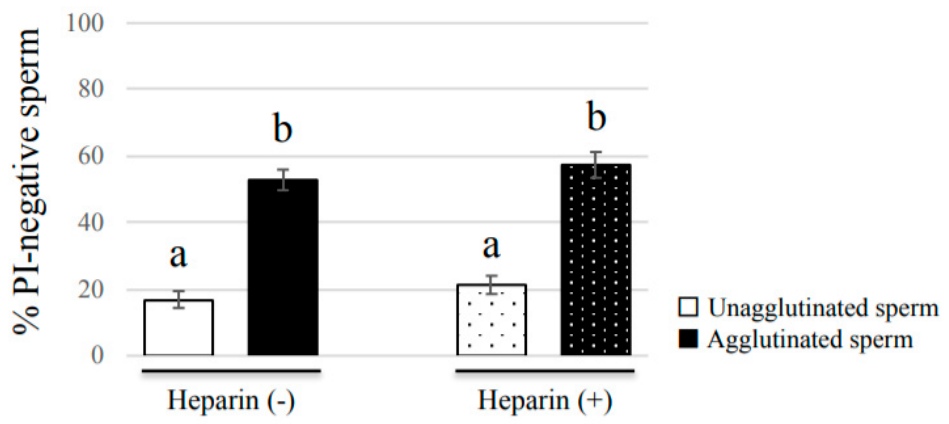
Figure 6. Effect of heparin on the % of PI-negative agglutinated or unagglutinated sperm. Bull sperm samples were stained with SYBR/PI, and incubated in non-capacitation medium supplemented with or without heparin for 2 h. Data shown as the mean ± SE ( n = 4). Different letters indicate a significant difference ( p < 0.01).